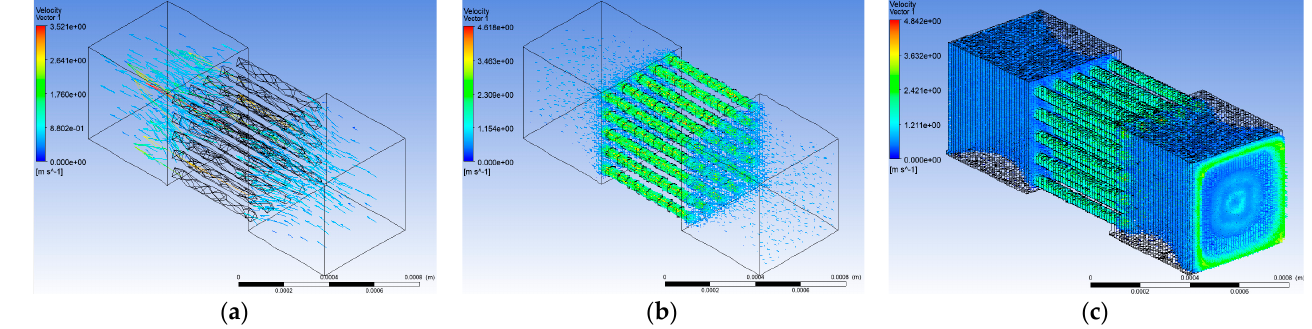
Figure 3. Air flow velocity vectorial solution in model of case I. ( a ) Low, ( b ) middle and ( c ) high detalization of porous mycelium media.